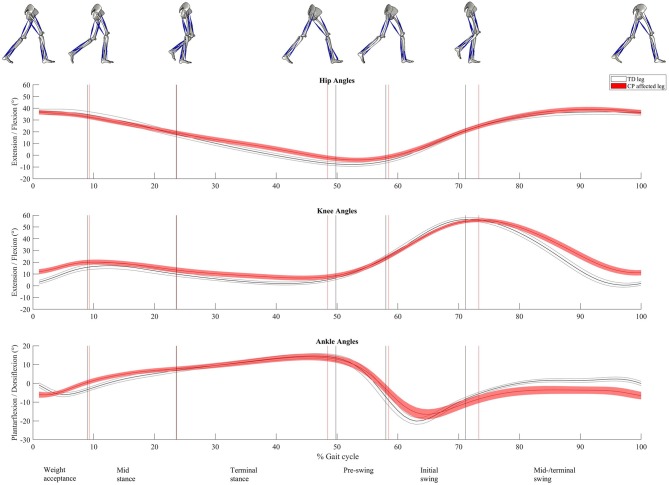
Sagittal-plane joint kinematics. At the top hip extension/flexion; in the middle, knee extension/flexion; and at the bottom, ankle plantarflexion/dorsiflexion. Time normalized to 0 to 100% of the gait cycle. Presented as mean (solid line) with 95% confidence interval (shaded area). The vertical lines represent the mean timing of the different events dividing the gait cycle into six gait phases (named at the bottom line). Gray color is used for the healthy legs of typically developing children and red for the affected legs of children with CP. Illustrations of the right leg's events, separating the different phases, are seen at the top.